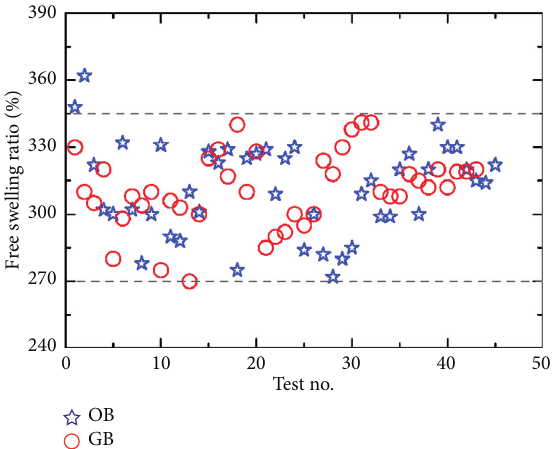
Figure 5: Free swelling ratios of original and granular bentonites.